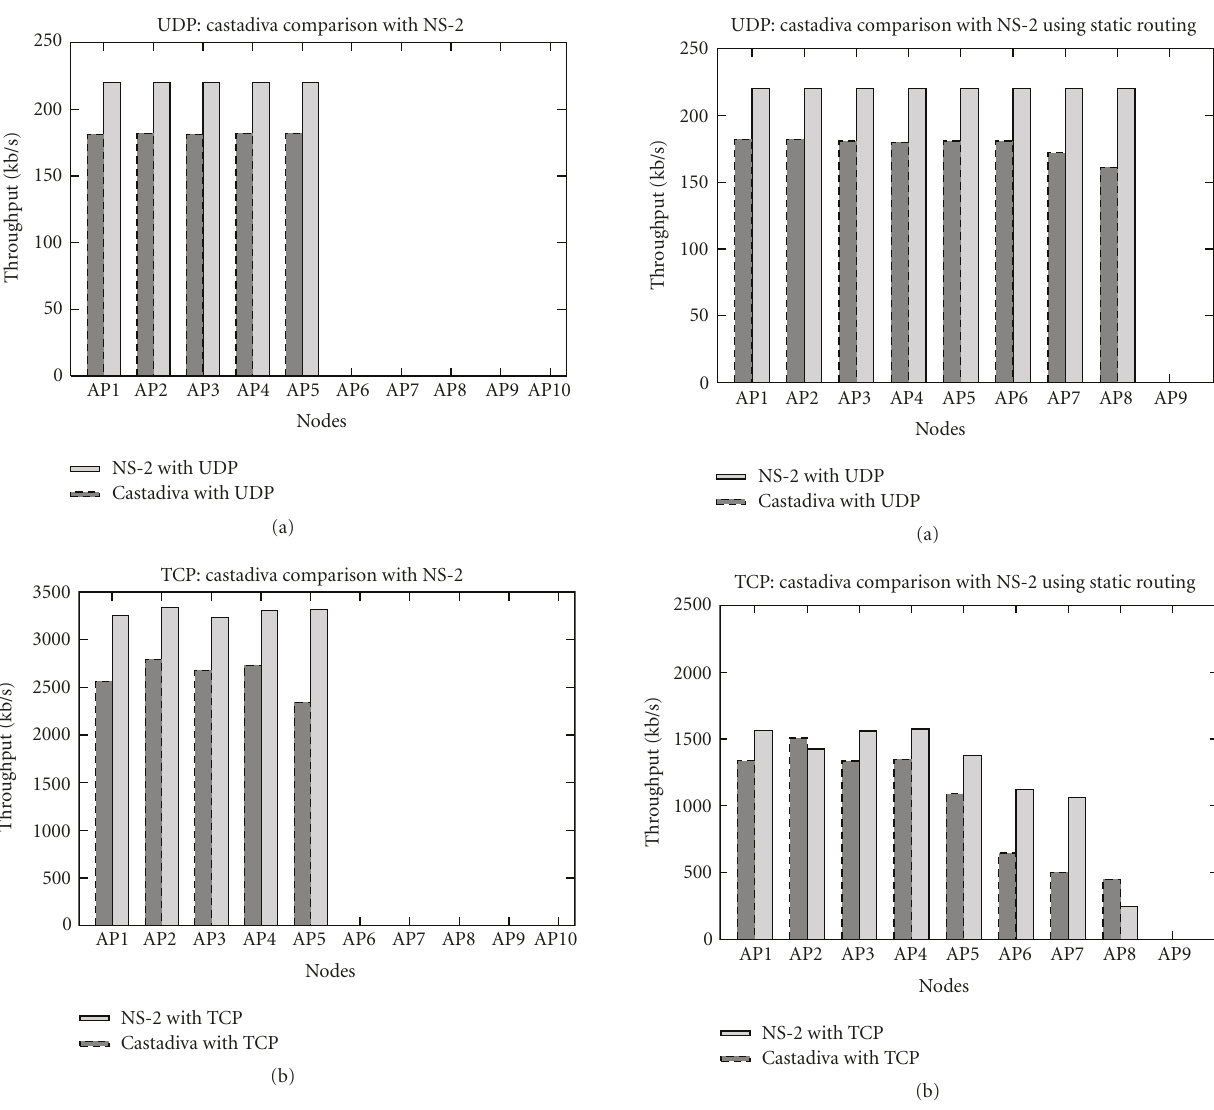
Figure 13: Performance comparison between Castadiva and ns-2 in a static scenario using CBR/UDP tra ffi c (a) and FTP/TCP tra ffi c (b). (routing disabled).